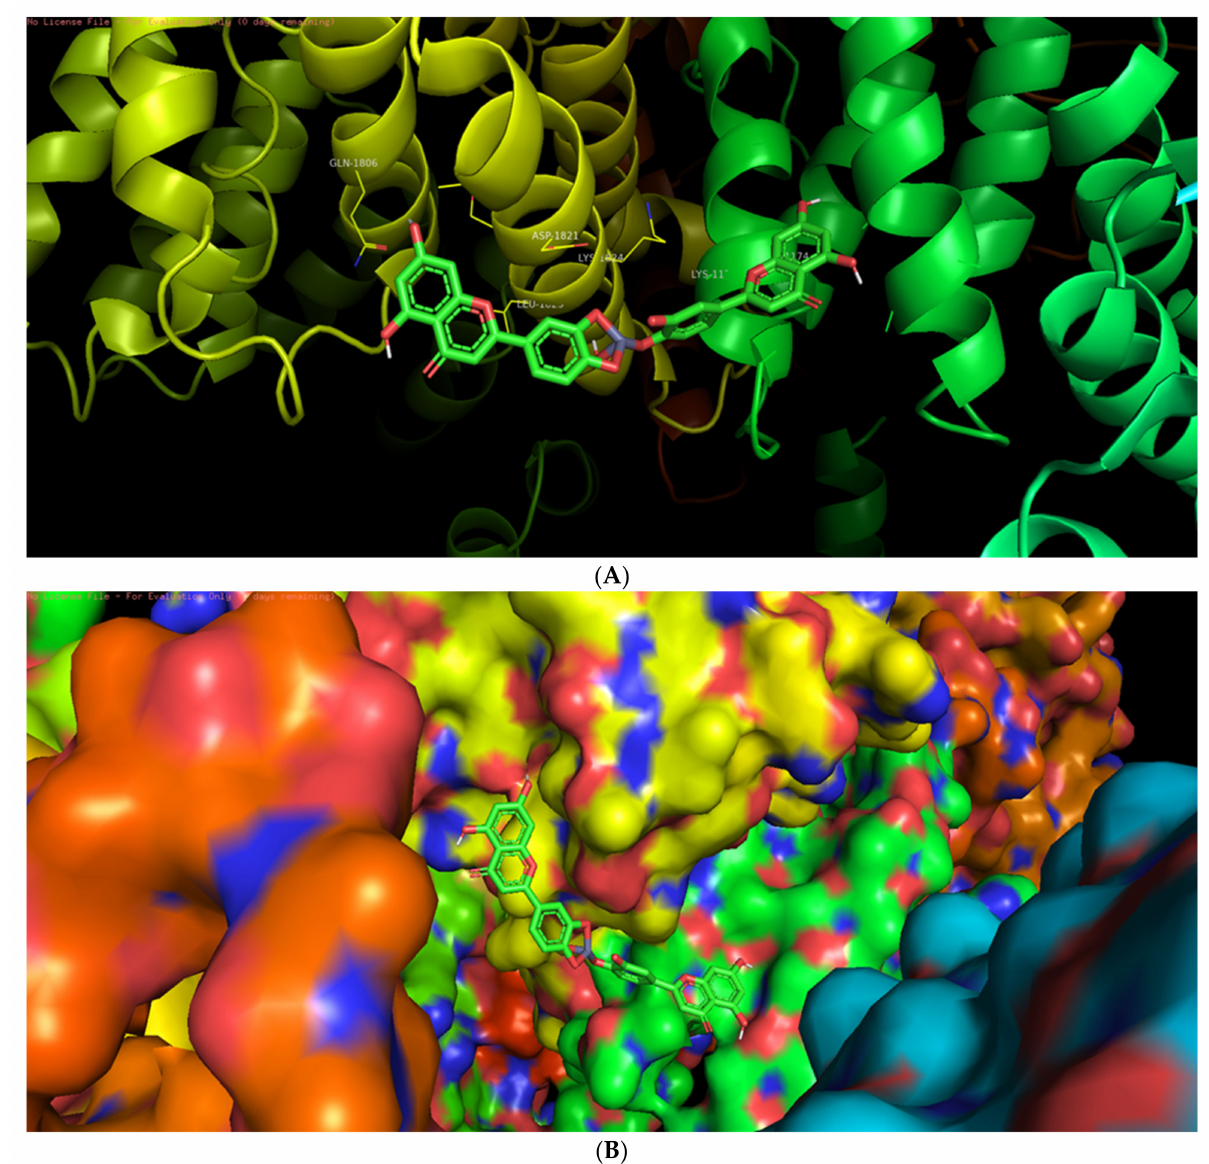
Figure 14. ( A ) The bonded and non-bonded interactions of L-ZnONPs with the cancer protein 5YZ0. ( B ) The best-docked pose of L-ZnONPs bound to the hydrophobic preset of the 5YZ0